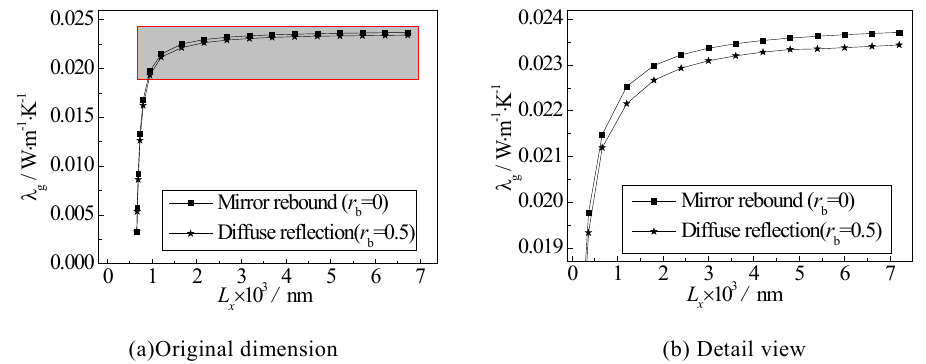
Fig. 6. Effective thermal conductivity of gas